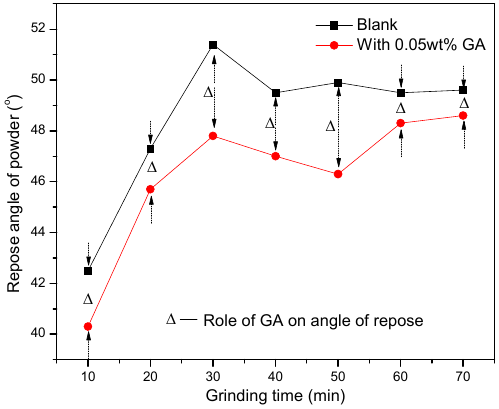
Figure 11. Repose angle of steel slag powder with GA vs. grinding time.